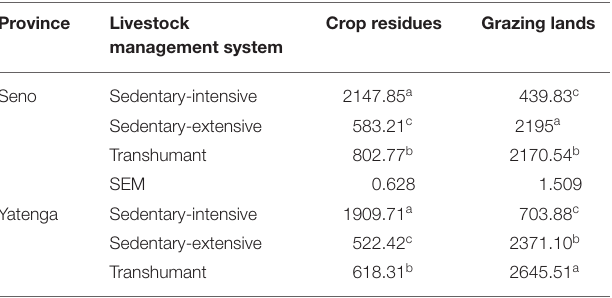
TABLE 2 | Livestock productivity (in TLU) in the study sites. Province Livestock management